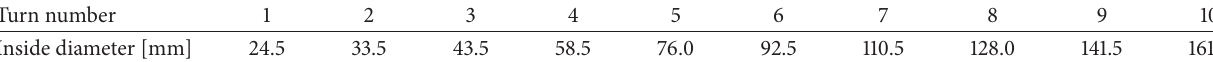
Table 1: Inner diameters of the optimised inductor turns.